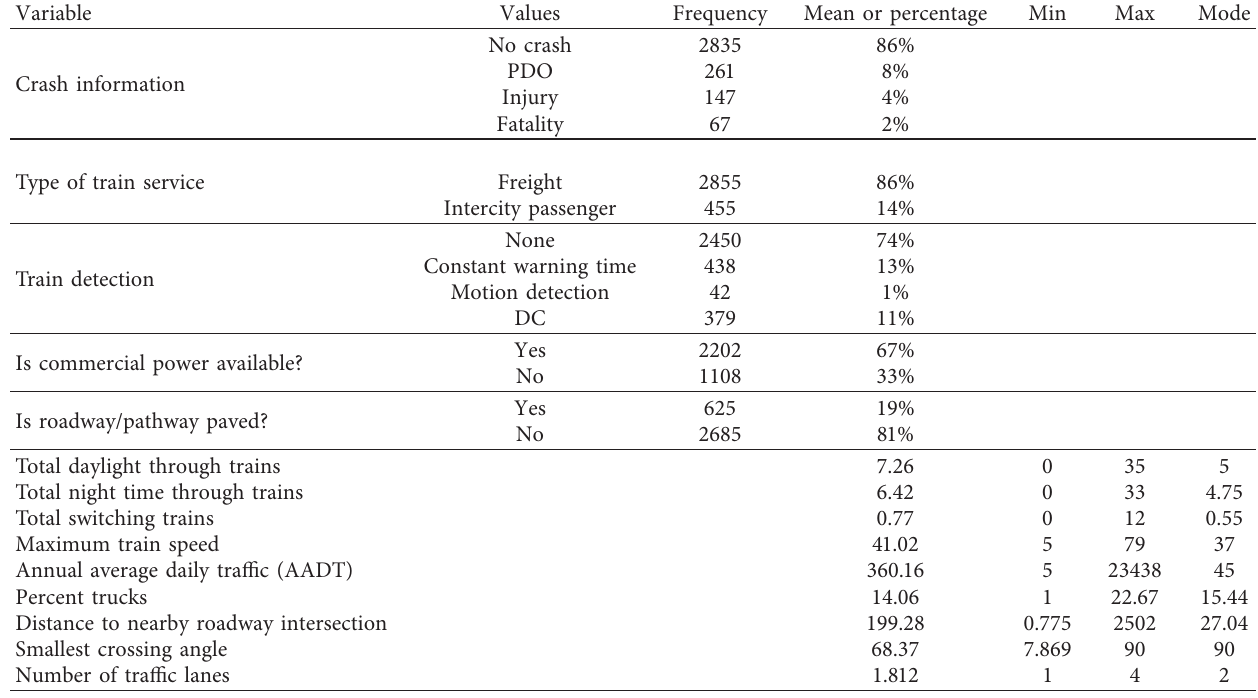
Table 1: Descriptive statistics of key